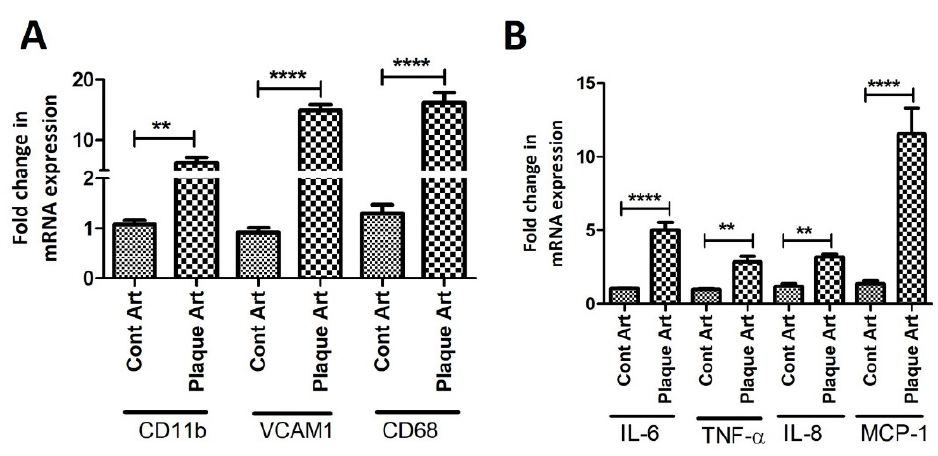
Figure 1. RT ‐ qPCR data for VSMCs phenotype markers in arteries with and without atherosclerotic plaques. Alpha ‐ smooth muscle actin ( α‐ SMA), transgelin (TAGLN), Myosin Heavy Chain 11 smooth muscle (Myh11), cytokeratin (CK) ‐ 18, S100 protein A4 (S100A4), calmodulin 2 (CALM2), Intercellular Adhesion Molecule (ICAM)1, Krüppel ‐ like factor 4 (KLF4). α‐ SMA, TAGLN, and Myh11 (markers for contractile vascular smooth muscle cells (VSMCs)); CK ‐ 18, S100A4, CALM2, and ICAM1 (markers for proliferative VSMCs); and KLF4 (a marker for de ‐ differentiated VSMCs). All data are presented as mean ± standard deviation (SD). p < 0.05 is considered statistically significant. ** p < 0.01 and **** p < 0.0001.